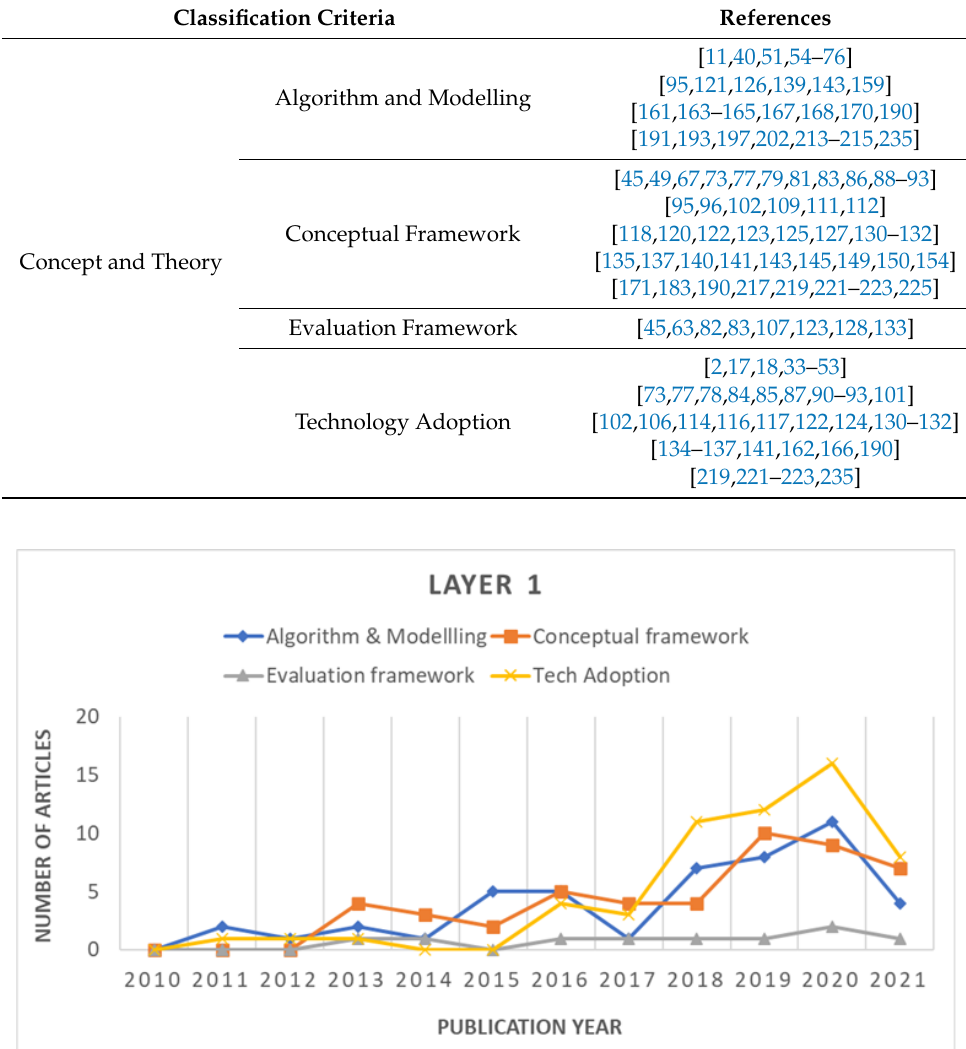
Table 9. Articles on Layer 1 Concept and Theory Layer.